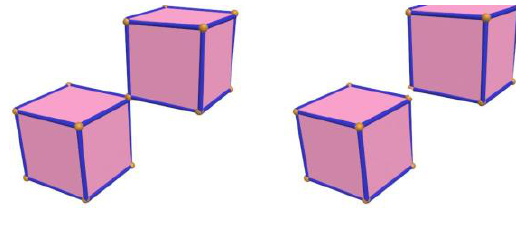
Figure 13. Healing CS_UMBRELLA error